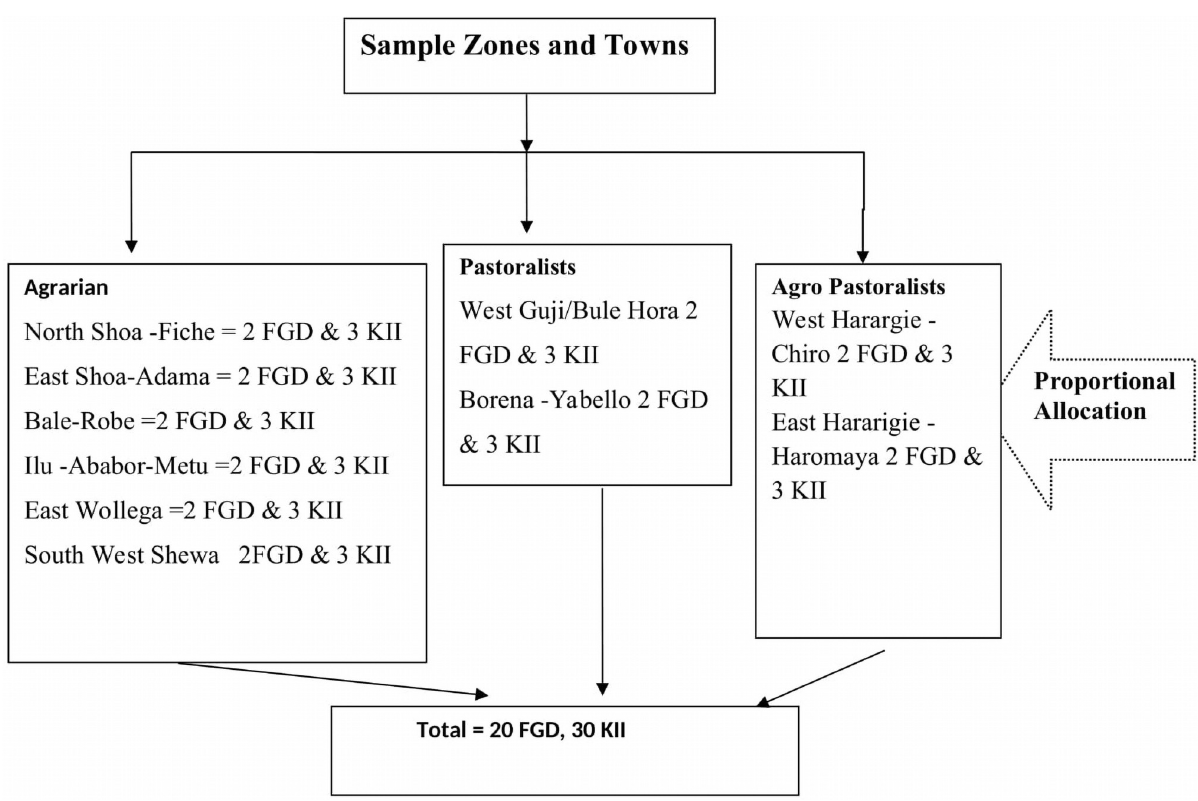
Fig 2. Schematic presentation of sampling procedure for qualitative methods, Oromia region, September 2020 to March 2021.